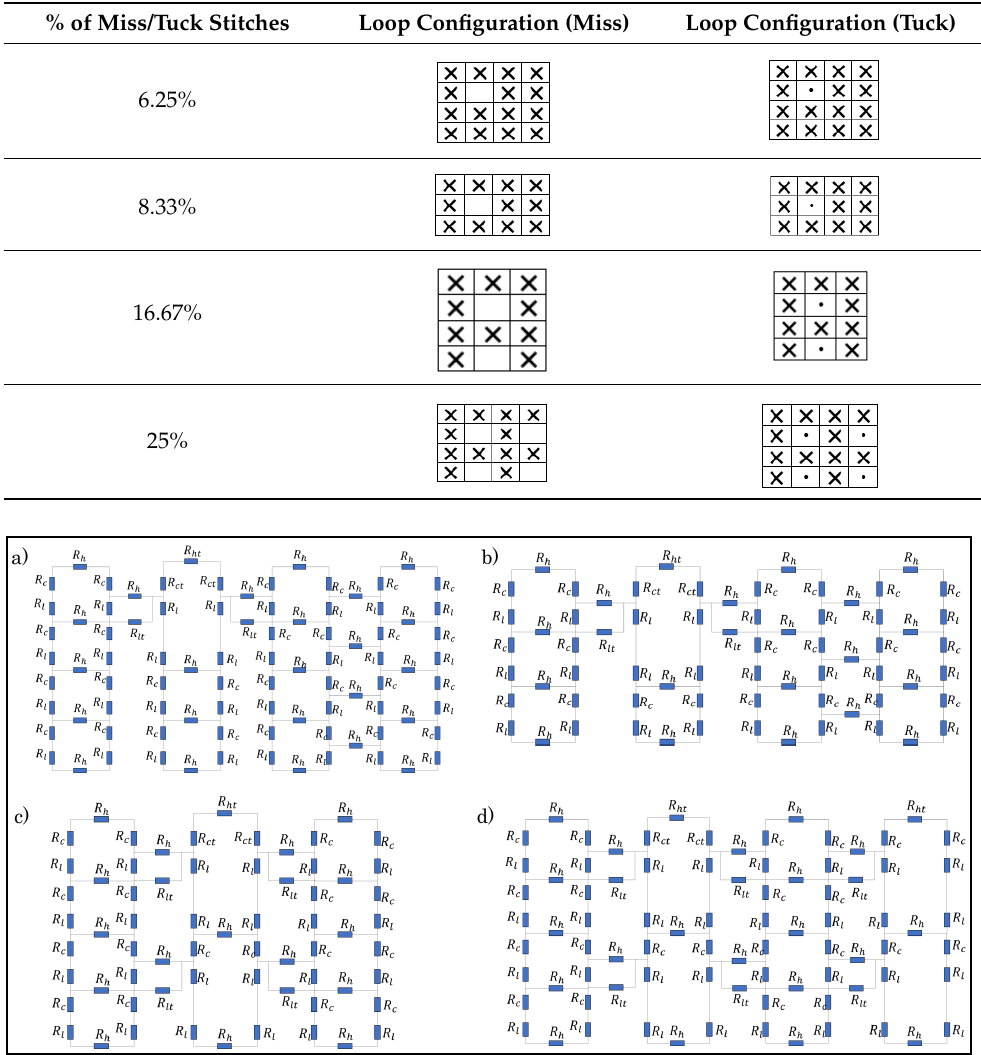
Table 1. Loop configuration of sensors. “ X ” represents a knitted loop stitch, “ ” represents a miss stitch and “ · ” represents a tuck stitch.